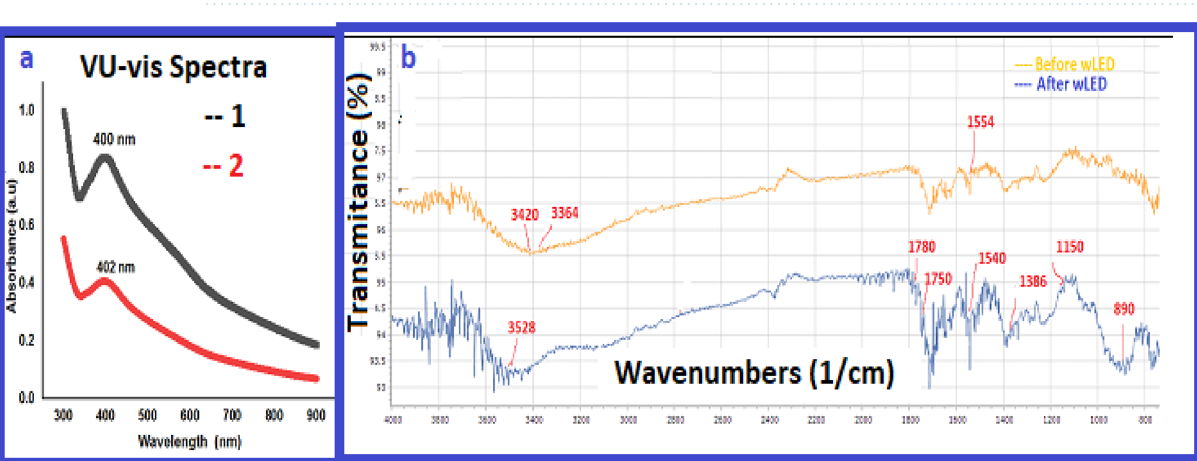
Figure 3. (a) UV–vis spectra of the AgNPs@C_MA_O (a) red spectra 1; and black spectra 2 is a spectra of a control group of free AgNPs, verifies that AgNPs in the AgNPs@C_MA_O not aggregated, (b) FTIR spectra of the AgNPs@C_MA_O before and after wLED